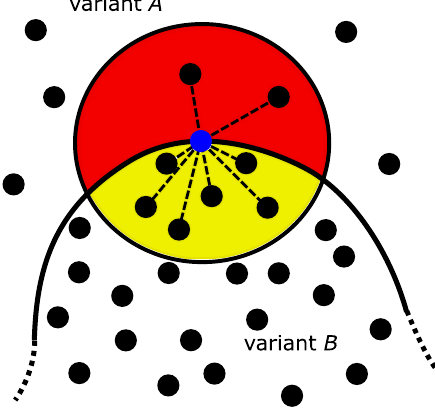
FIG. 4. Behavior of an isogloss surrounding a densely popu- lated area. The blue dot represents a speaker on the isogloss between variants A and B . Other speakers are shown as black dots. The circle around our speaker represents their typical range of interaction. Within red shaded part of this interaction range, variant A is more common, and in the yellow shaded part, variant B is more common. Because of variation in population density, they hear more of variant B (dashed lines indicate interactions) despite the fact that a greater area (red shaded) of their interaction range lies within the domain of variant A .